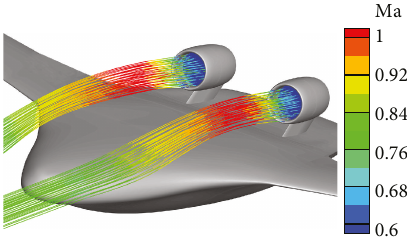
Figure 25: The in fl ow streamlines of the BWB300 at the cruise